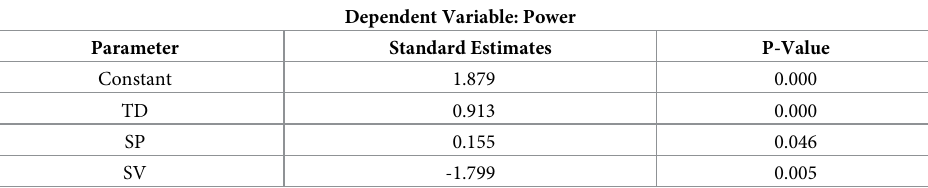
Table 7. Statistical analysis of power for heterogeneous 3D